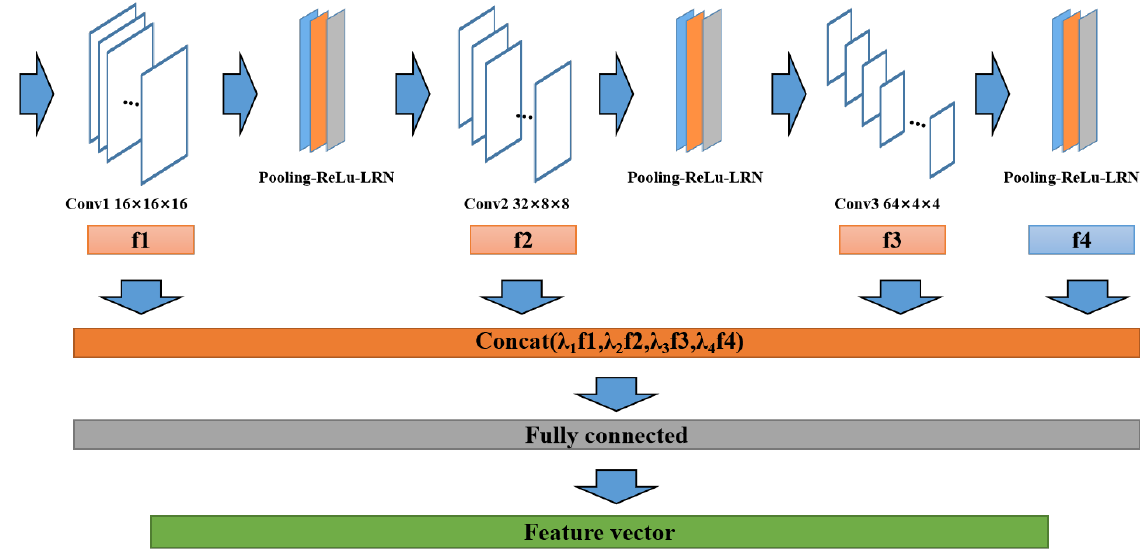
Figure 1. CSPFE-NET